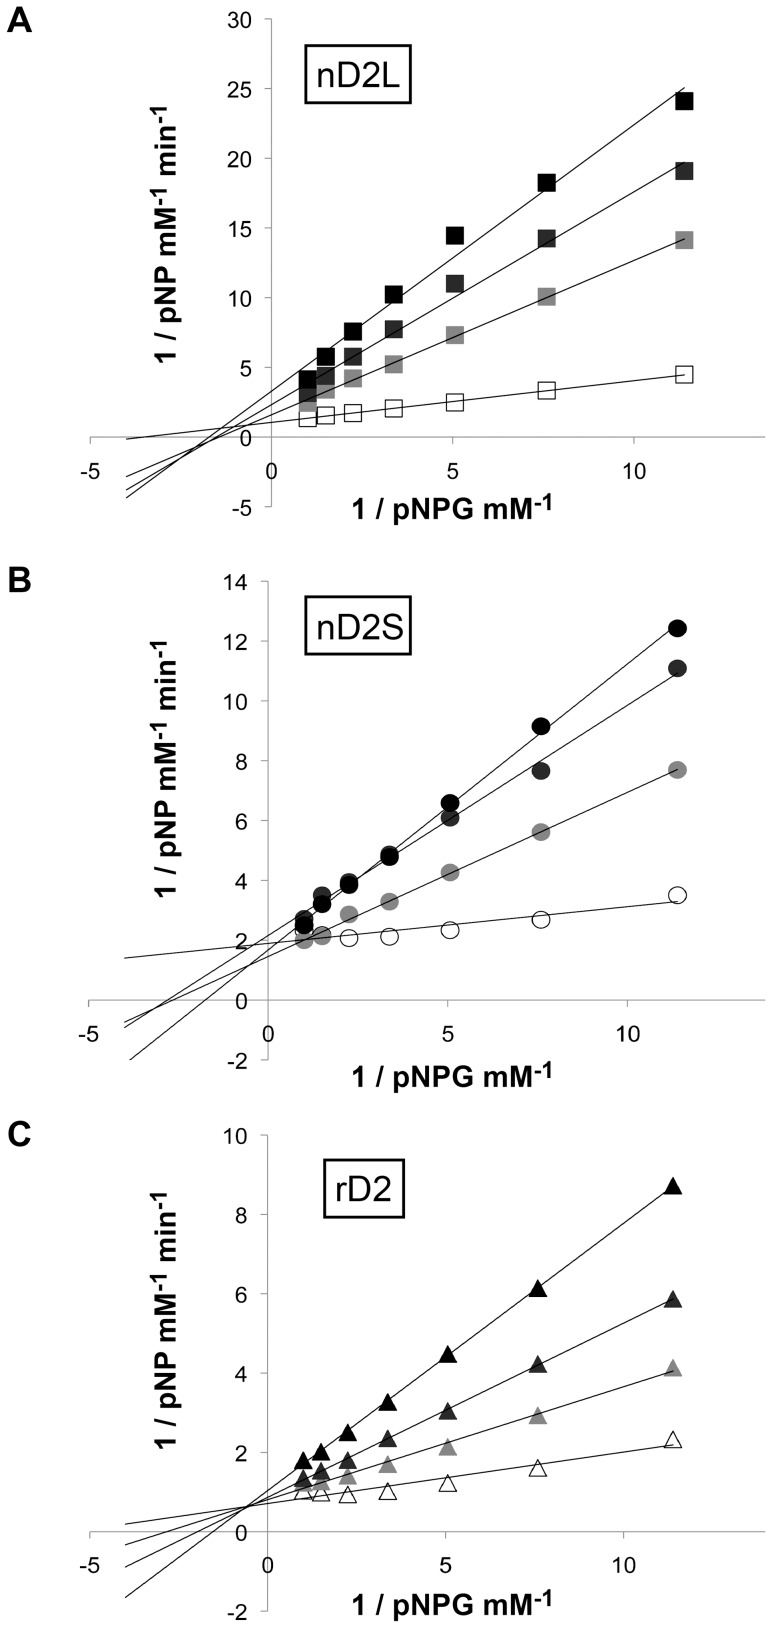
Glucose inhibition of nD2L in pNPG assay is noncompetitive.Lineweaver-Burk plots of pNPG activity of D2 variants in the presence of glucose. (A) nD2L, (B) nD2S, (C) rD2. Open symbols: 0 mM, light gray: 3 mM, dark gray: 6 mM, black: 9 mM glucose.